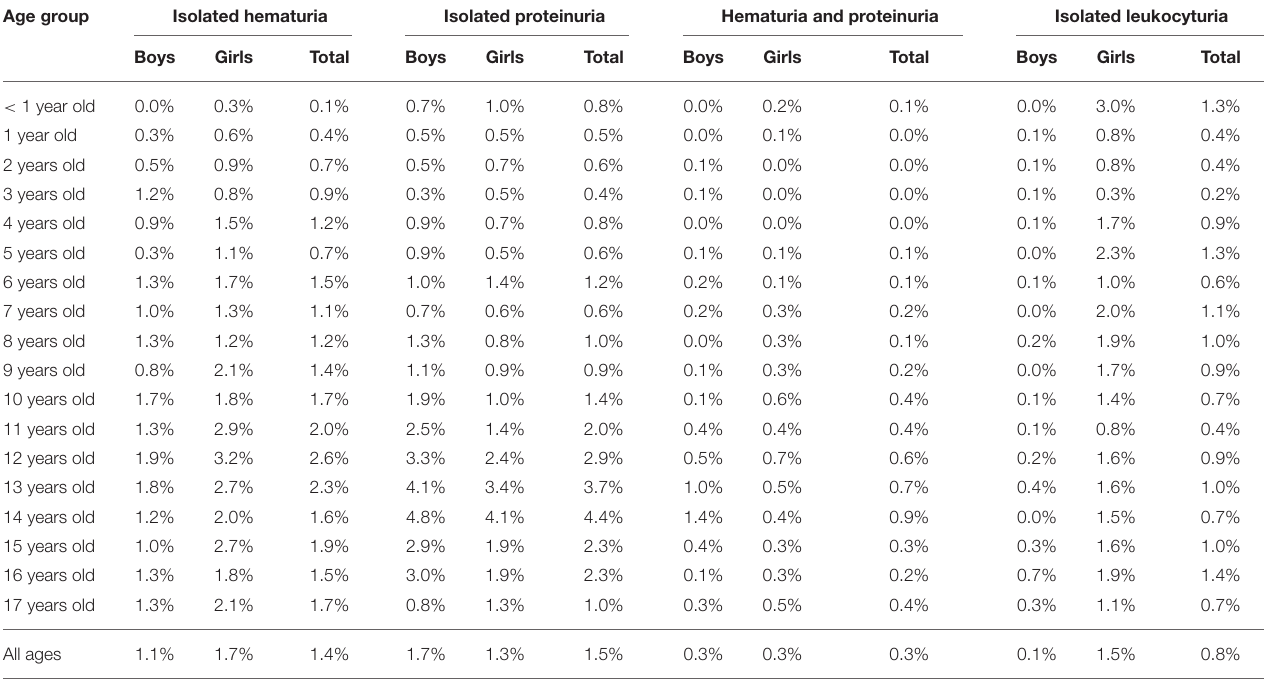
TABLE 2 | Patterns of abnormal urinalysis in children. Age group